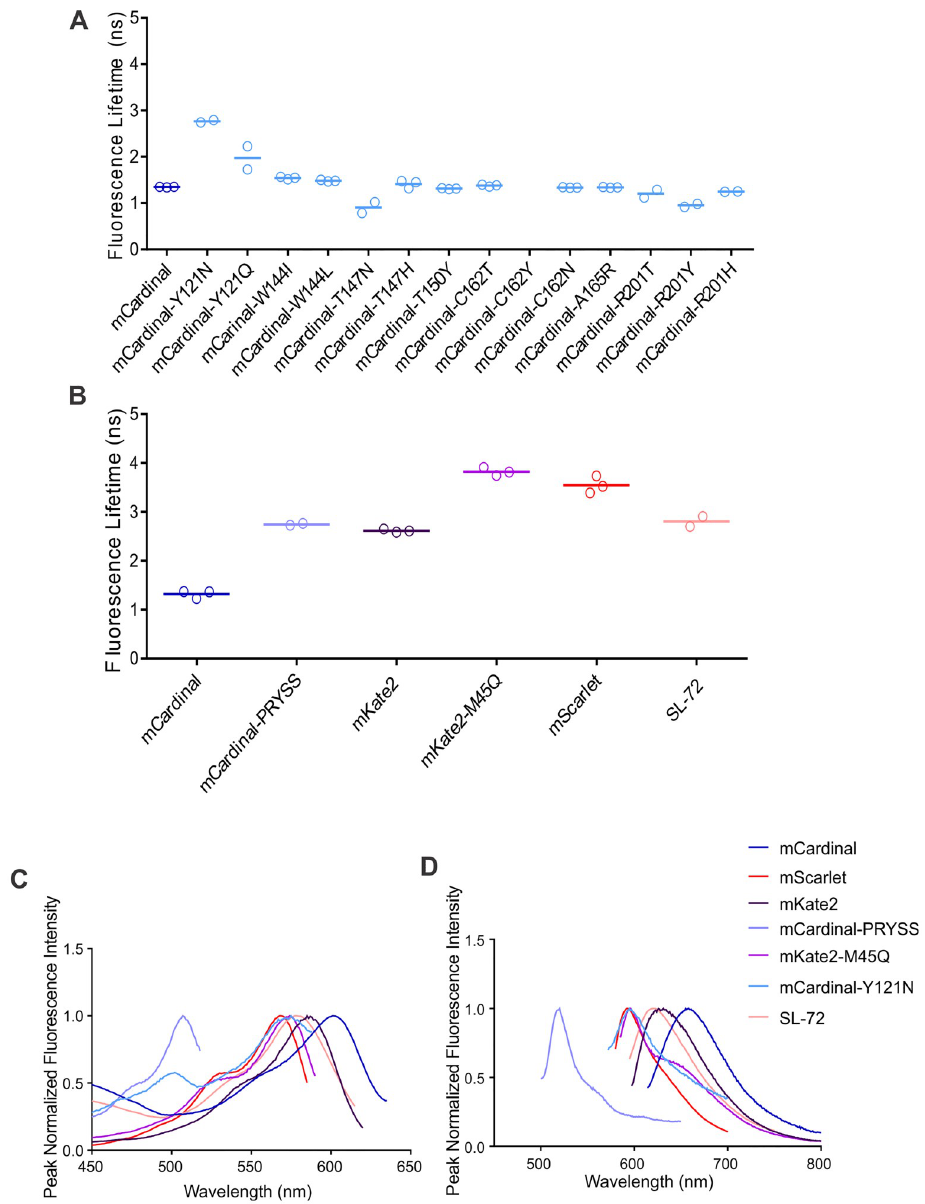
Fig 1. A Fluorescence lifetime measurements of mutants from site-directed mutagenesis of mCardinal measured in HEK393T cells by FLIM. B Fluorescence lifetime measurement of mutants from site-directed mutagenesis of mCardinal and mKate2 (in HEK293T cell lysates) and SL72 from the mScarlet/mCardinal shuffle library (in bacterial suspension) measured on the PTI fluorimeter. C Excitation and D Emission spectra of fluorescence proteins with the longest fluorescence lifetimes in HEK293T cell lysates, made by site-directed mutagenesis and SL72 from the mCardinal/mScarlet Shuffle library (measured in bacterial suspension).